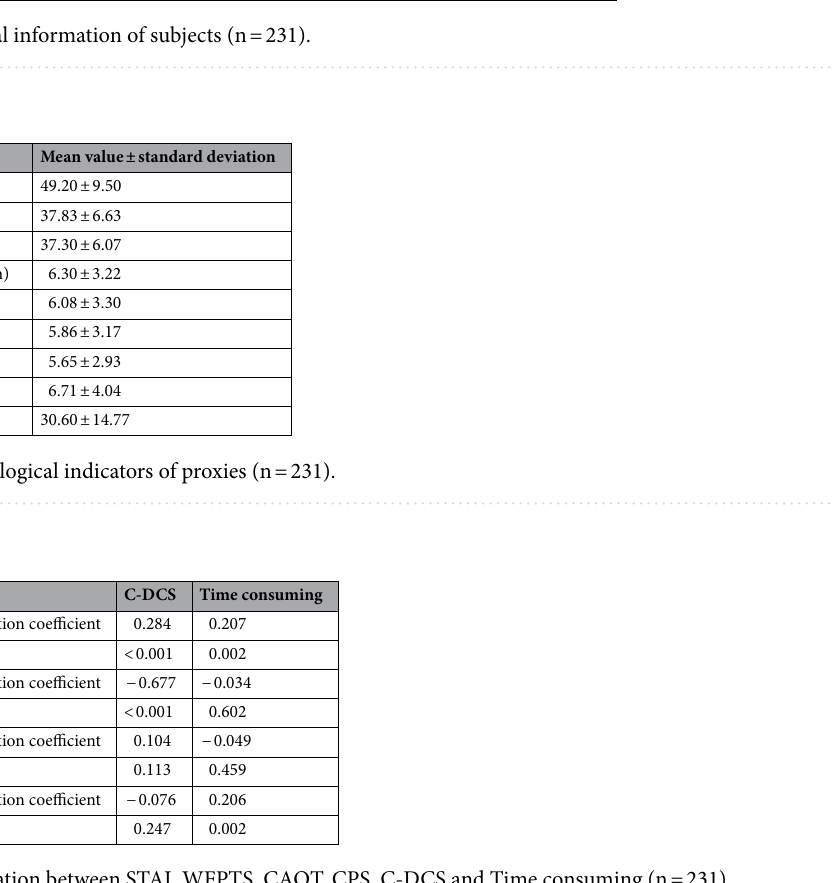
Table 3. Correlation between STAI, WFPTS, CAOT, CPS, C-DCS and Time consuming (n =